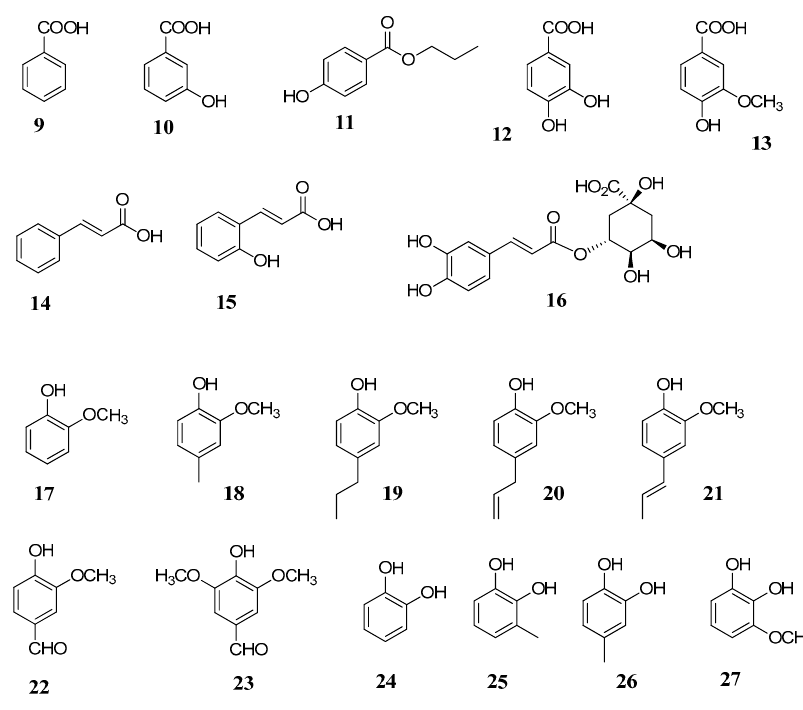
Figure 7. Structures of tested phenols: benzoic acid ( 9 ), m -benzoic acid ( 10 ), propylparaben ( 11 ), protocatechuic acid ( 12 ), vanillic acid ( 13 ), cinnamic acid ( 14 ), o -coumaric acid ( 15 ), chlorogenic acid ( 16 ), guaiacol ( 17 ), 4-methylguaiacol ( 18 ), 4-propylguaiacol ( 19 ), eugenol ( 20 ), isoeugenol ( 21 ), vanillin ( 22 ), syringaldehyde ( 23 ), catechol ( 24 ), 3-methylcatechol ( 25 ), 4-methylcatechol ( 26 ), 3-methoxycatechol ( 27 ) [45].